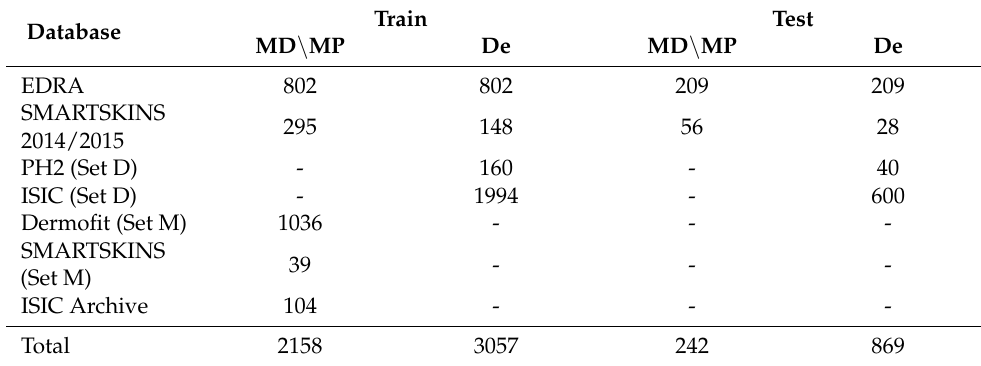
Table 2. Formation of dermoscopic and macroscopic datasets and separation into train and test